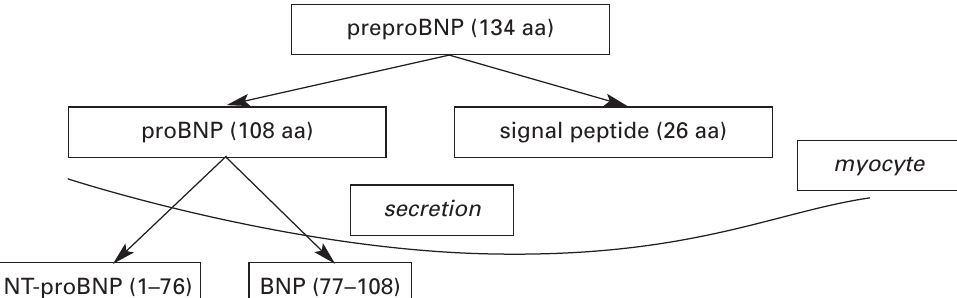
BNP is produced from the car- diac myocytes as a prepro hor- mone of 134 amino acids, which is clipped into a proBNP hor- mone. Upon stimulus for secre- tion, it is released into the blood as the fragment protein N-termi- nal proBNP and the BNP mole- cule itself. The N-terminal por- tion is made of 77 amino acids and is a biologically inactive protein. BNP holds the biological